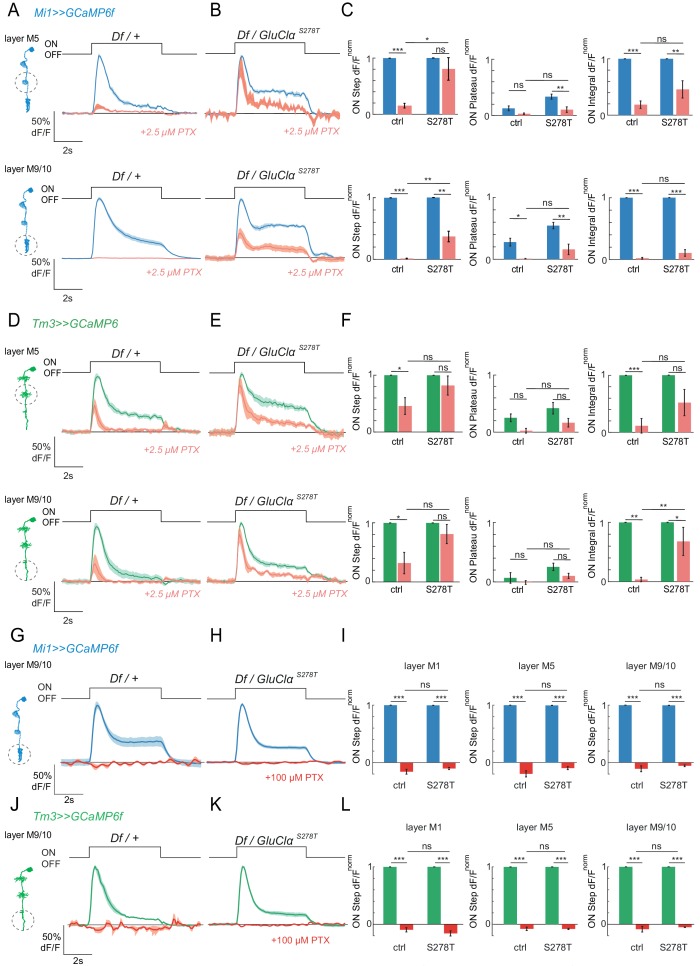
Pharmacogenetics shows that ON responses are mediated by GluClα.(A,B) In vivo calcium signals in response to full-field flashes recorded in layers M5 and M9/10 of Mi1 neurons. Figure shows traces before (blue) and after (red) application of 2.5 µM PTX in heterozygous GluClαDf/+ controls (A, n = 5[44]/[63]), or flies only expressing the PTX-insensitive GluClαS278T allele (GluClαS278T/GluClαDf) (B, n = 5 [49]/[47]). Sample sizes are given as number of flies (number of cells in M5/M9/10). (C) Bar plots showing the quantification of the data shown in (A,B). (D,E) In vivo calcium signals in response to full field stimulation recorded in layers M5 and M9/10 of Tm3 neurons. Shown are traces before (green) and after (red) PTX application in heterozygous GluClαDf/+ controls (D, n = 5 [33]/[30]), or flies only expressing the PTX-insensitive GluClαS278T allele (GluClαS278T/GluClαDf) (E, n = 5 [37]/[40]). Sample sizes are given as number of flies [number of cells in M5/M9/10]. (F) Bar plots showing the quantification of the normalized data from (D,E). (G,H,J,K) In vivo calcium signals in response to full-field flashes recorded in layer M9/10 of Mi1 (G,H) or Tm3 (J,K) neurons. Figure shows traces before (blue/green) and after (red) application of 100 µm PTX in heterozygous GluClαDf/+ controls (G, n = 5[54]; J, n = 4[73]), or flies only expressing the PTX-insensitive GluClαS278T allele (GluClαS278T/GluClαDf) (H, n = 6[78]; K, n = 5[57]). (I,L) Bar plots showing the quantification for Mi1 (I) and Tm3 (L). Sample sizes are shown as number of flies [number of cells]. All traces show mean ± SEM. *p<0.05, **p<0.01, ***p<0.001, tested with an unbalanced two-way ANOVA, corrected for multiple comparisons in (C,F,I,L).10.7554/eLife.49373.023Figure 6—figure supplement 1—source data 1.Table 1 contains all mean ± s.e.m.Data related to quantifications shown in main Figure 6—figure supplement 1, sorted by genotype and experimental condition.